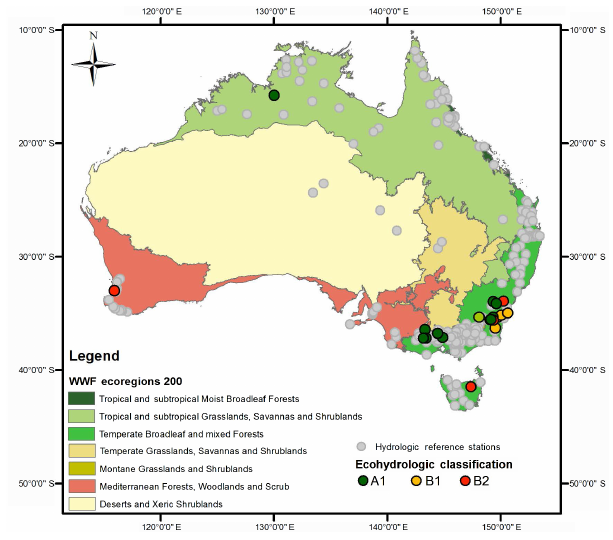
Figure 1. Distribution of hydrologic reference stations across Aus- tralia. Colored circles represent catchments with a significant trend in annual runoff ratio. Colors represent catchment grouping based on the classification framework of Fig. 6. The catchments with non- stationary hydrologic response span over three significant ecore- gions of the continent. Ecoregion boundaries are from the World Wildlife Fund